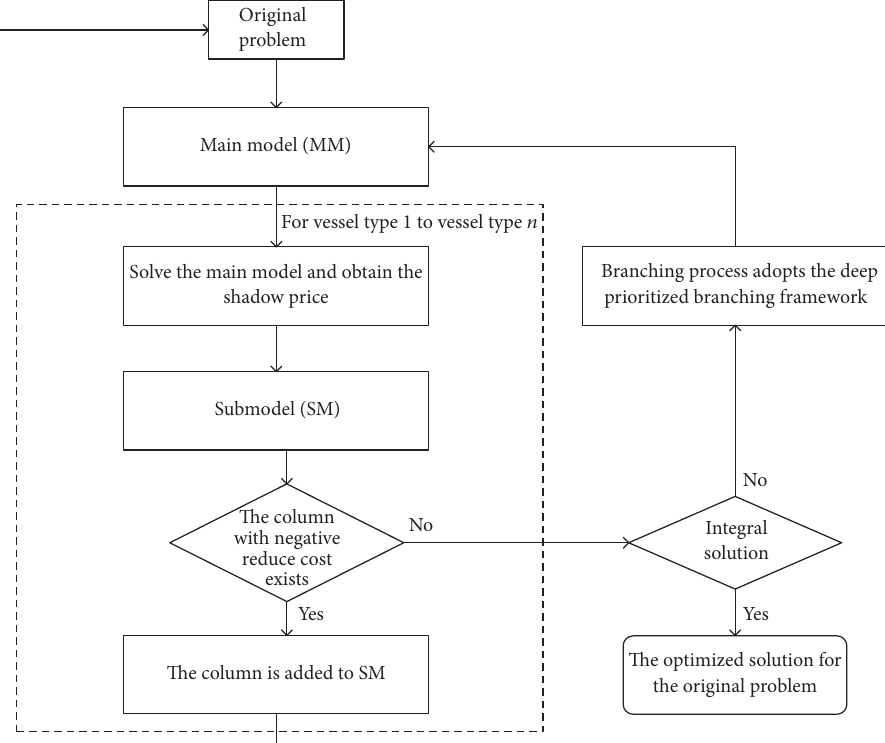
Figure 3: Diagram of branch-and-price